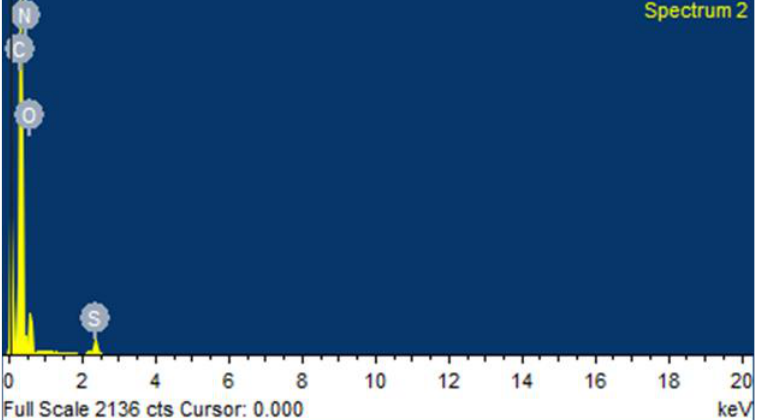
Figure 2. Energy dispersive spectroscopy (EDS) analysis of chitosan-encapsulated meloxicam nanoparticles (CEMNPs).